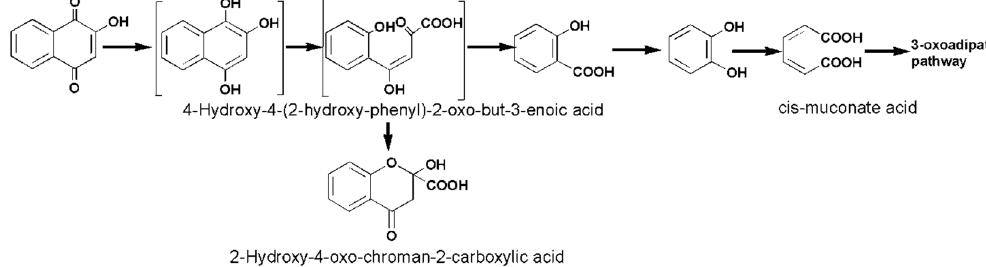
Figure 5. Proposed metabolic pathway of lawsone by strain LH-3. (The compounds shown in the brackets were not detected but speculated to be present in the system).